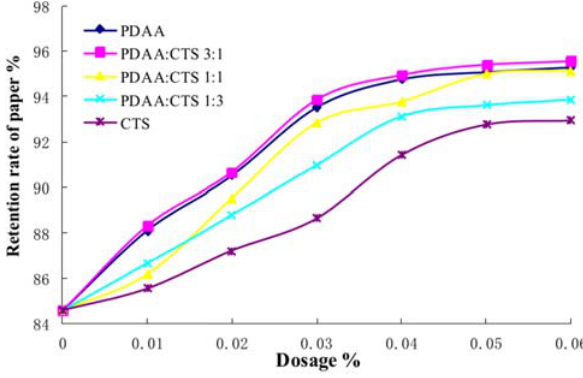
Figure 10: Synergistic retention of PDAA/CTS. The molecular weight of PDAA is 4 million.